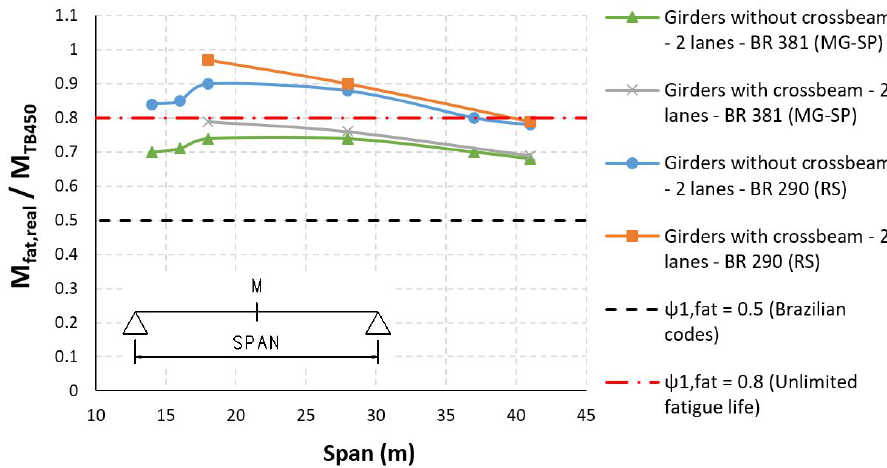
Figure 19. Bias factors for bending moment at mid-span in simply supported girder bridges.